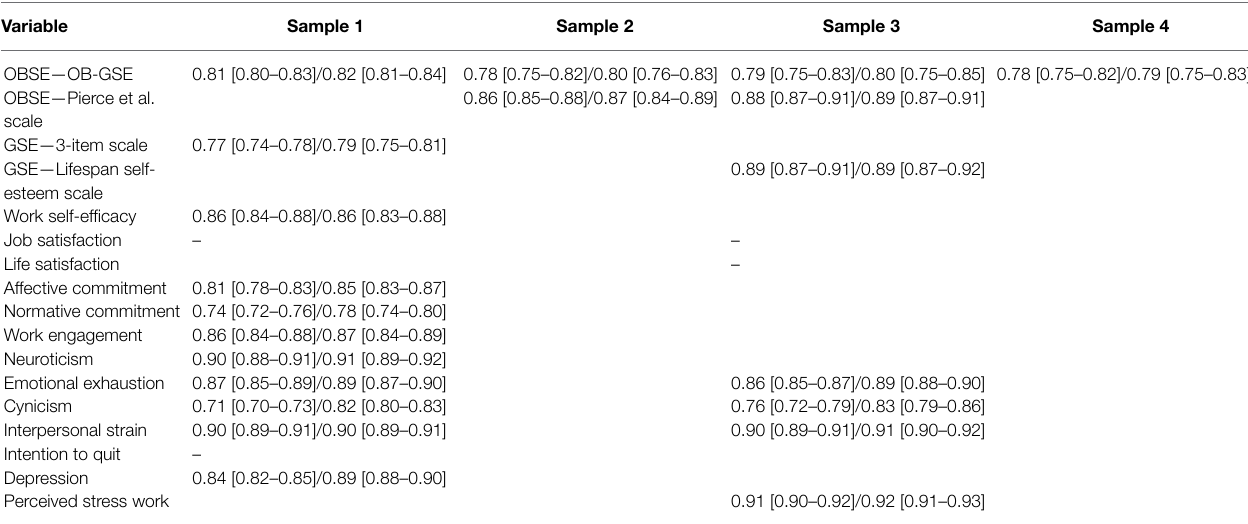
TABLE 3 | Cronbach’s alpha and omega coefficient, with confidence intervals, of study variables across samples.